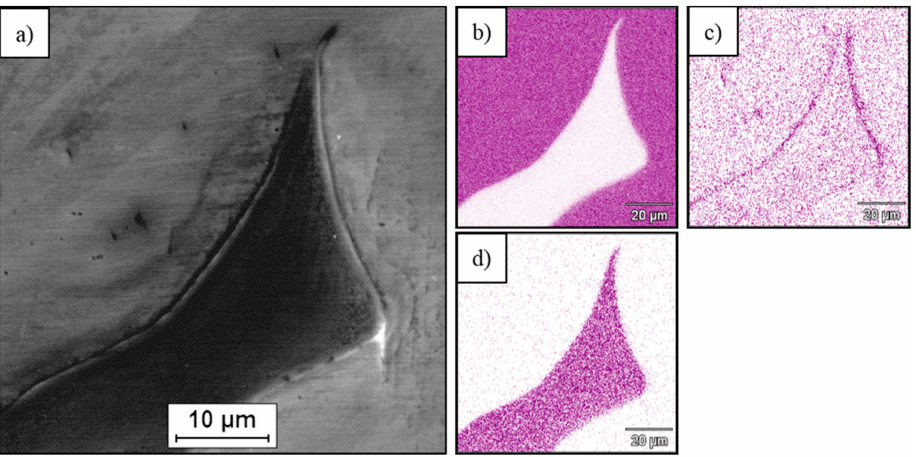
Figure 6. ( a ) SEM micrograph of C of –Mg composite with X-ray mapping of elements: ( b ) Mg, ( c ) O and ( d ) C.